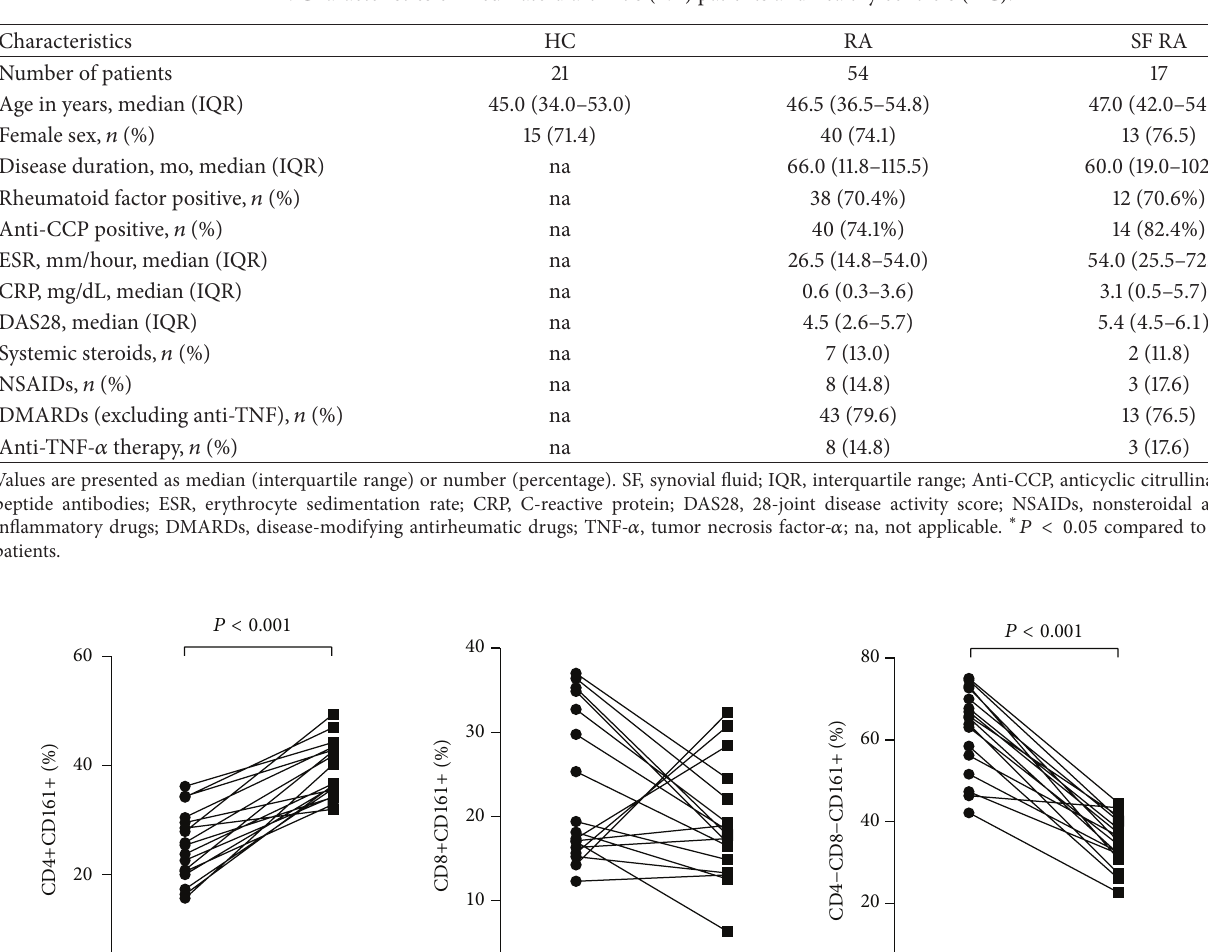
Table 1: Characteristics of rheumatoid arthritis (RA) patients and healthy controls (HC).